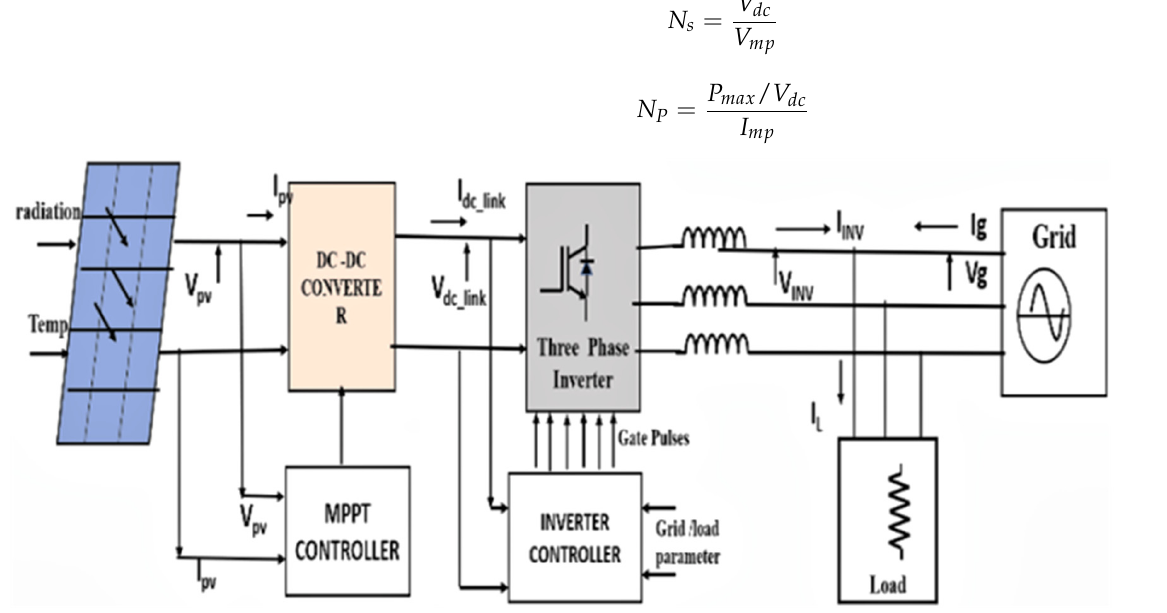
Figure 1. Block diagram of solar photovoltaic system.